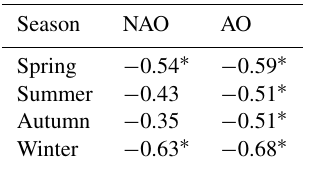
Table 6. The correlation coefficients between the 1000hPa first PCA component and the NAO and AO indices; asterisks mark sta- tistically significant correlations ( α =